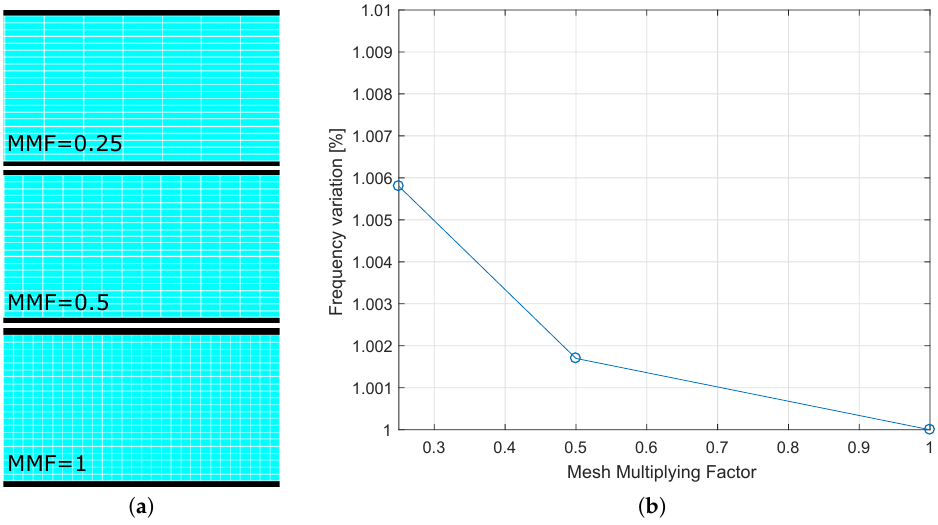
Figure 5. ( a ) Blade-strip contact interface with different mesh multiplying factors ( MMF ). ( b ) Frequency increment produced by mesh size variations expressed through the MMF